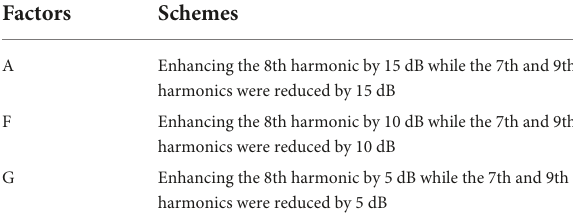
TABLE 4 Factors used for each of the three audio materials in investigation 2.